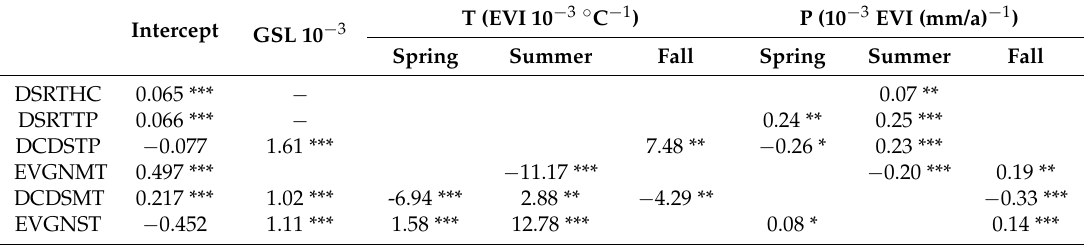
Table 6. Regression coefficients of annual average EVI on seasonal mean temperature and precipitation. p values were based on one-tailed hypothesis, and “*”, “**”, and “***” are for p -values less than 0.1, 0.05, and 0.01,